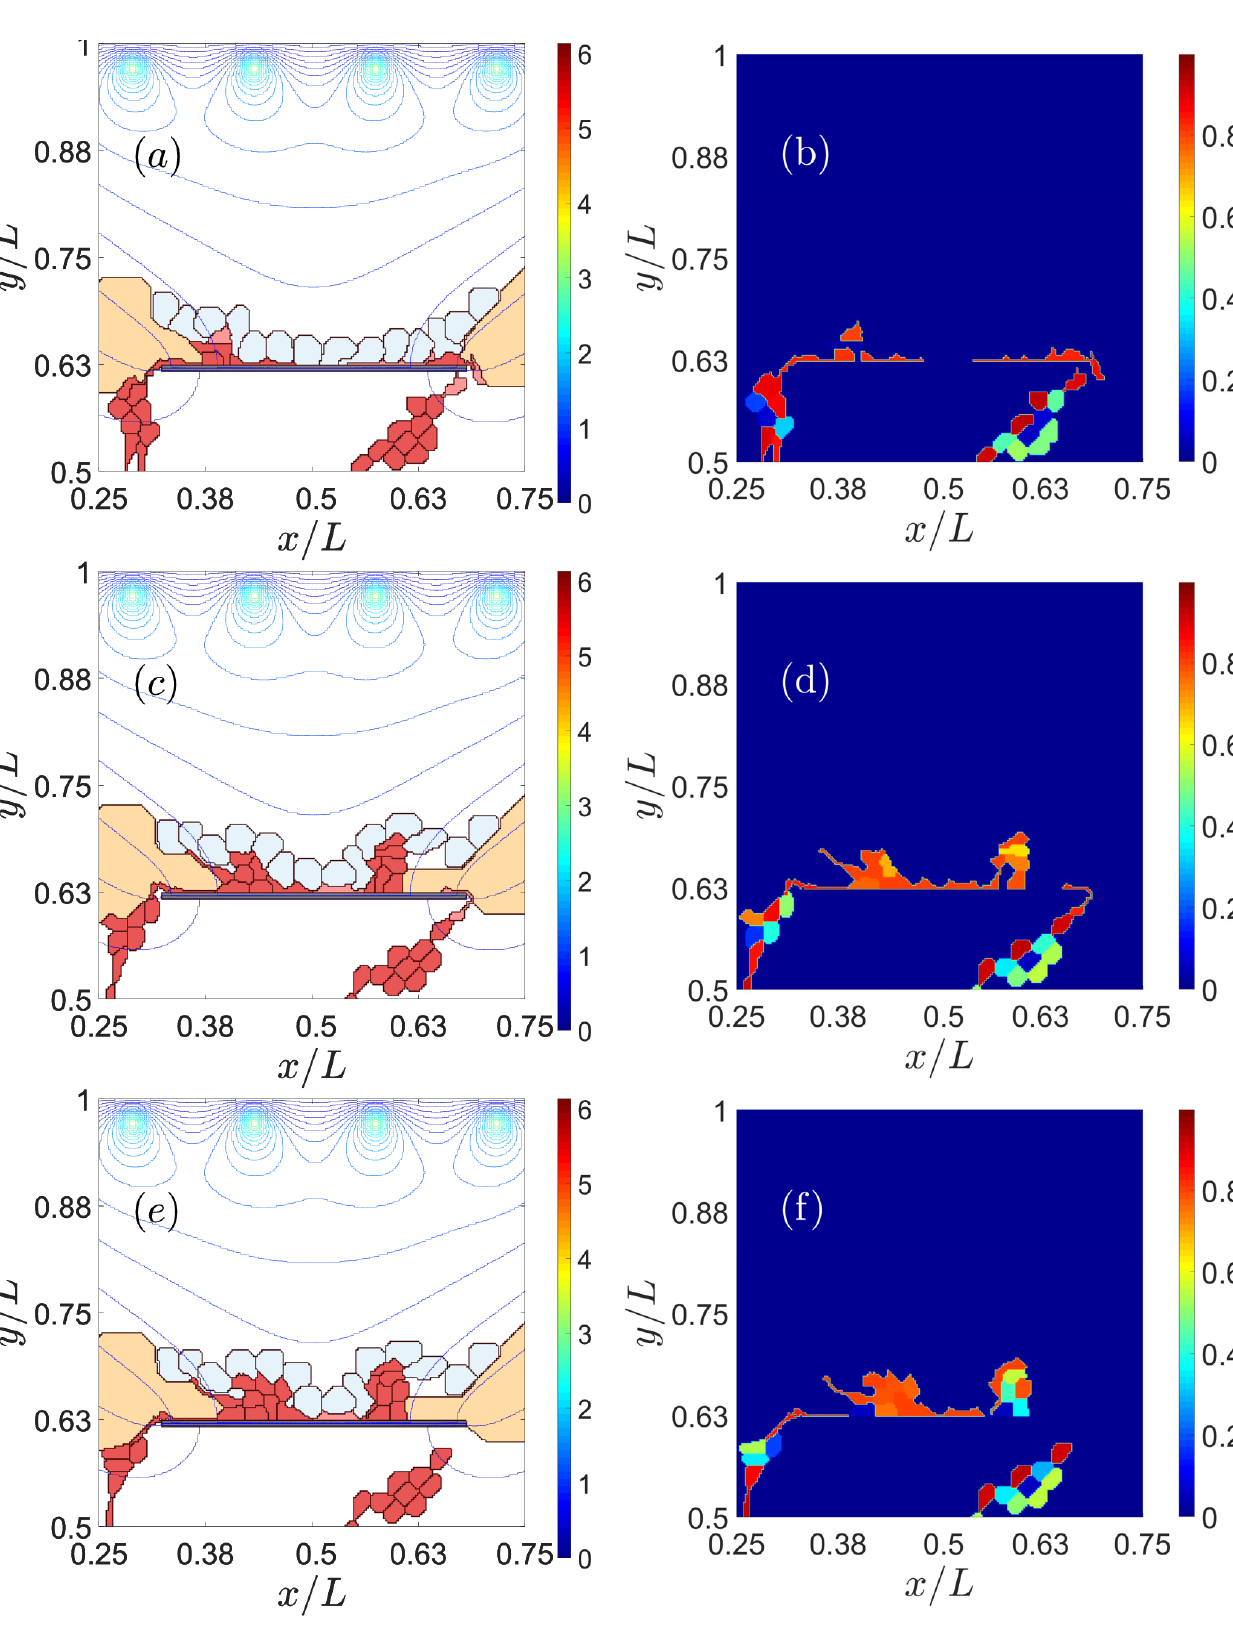
Figure 5. Type 1 CNV due to the lack of VEGF in the point where the tip cell of the sprout tries to cross the RPE (left column: ( a ), ( c ), ( e )). Amount of VEGF receptors of ECs (right column: ( b ), ( d ), ( f )). Snapshots at times: ( a ), ( b ) 1501 MCTS, ( c ), ( d ) 4501 MCTS, ( e ), ( f ) 9001